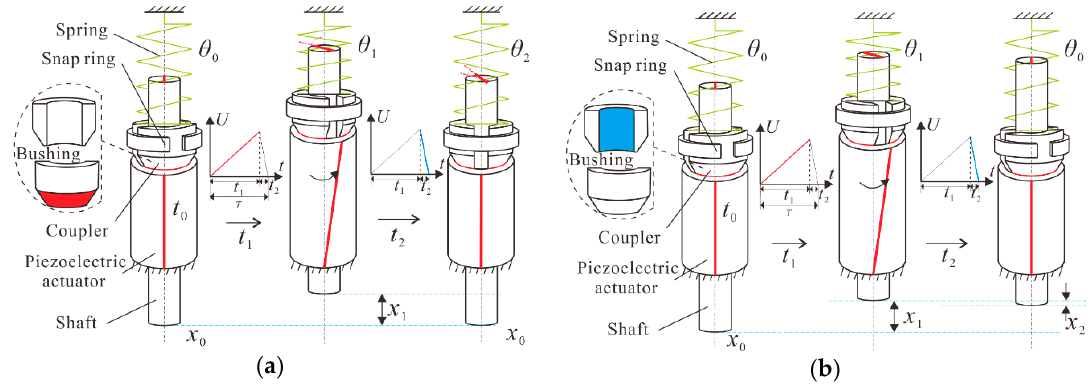
Figure 2. Working principle of the piezoelectric motor: ( a ) rotary motion; ( b ) linear